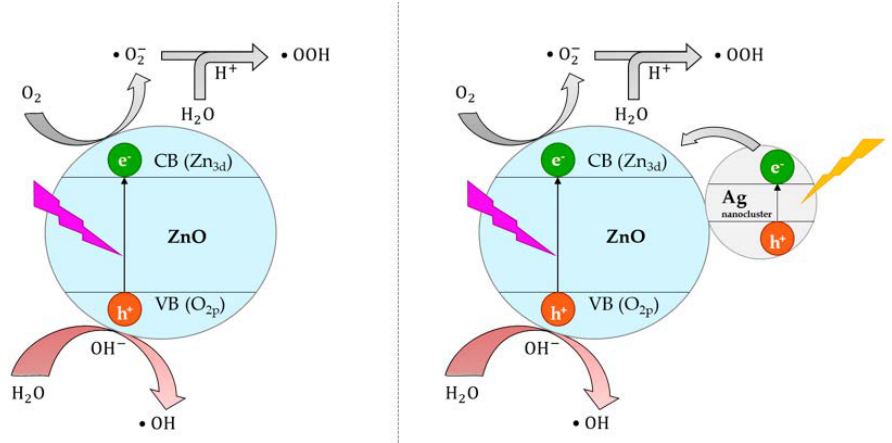
Figure 1. General mechanism of semiconductor photocatalysis ( left ) and modification of energy levels with the incorporation of silver nanoclusters ( right ).